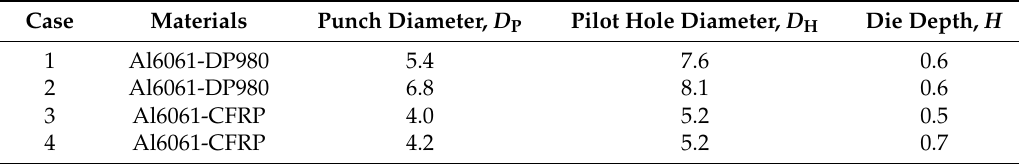
Figure 3. Hole-clinching machine and tools. Table 2. Process conditions of hole-clinching.